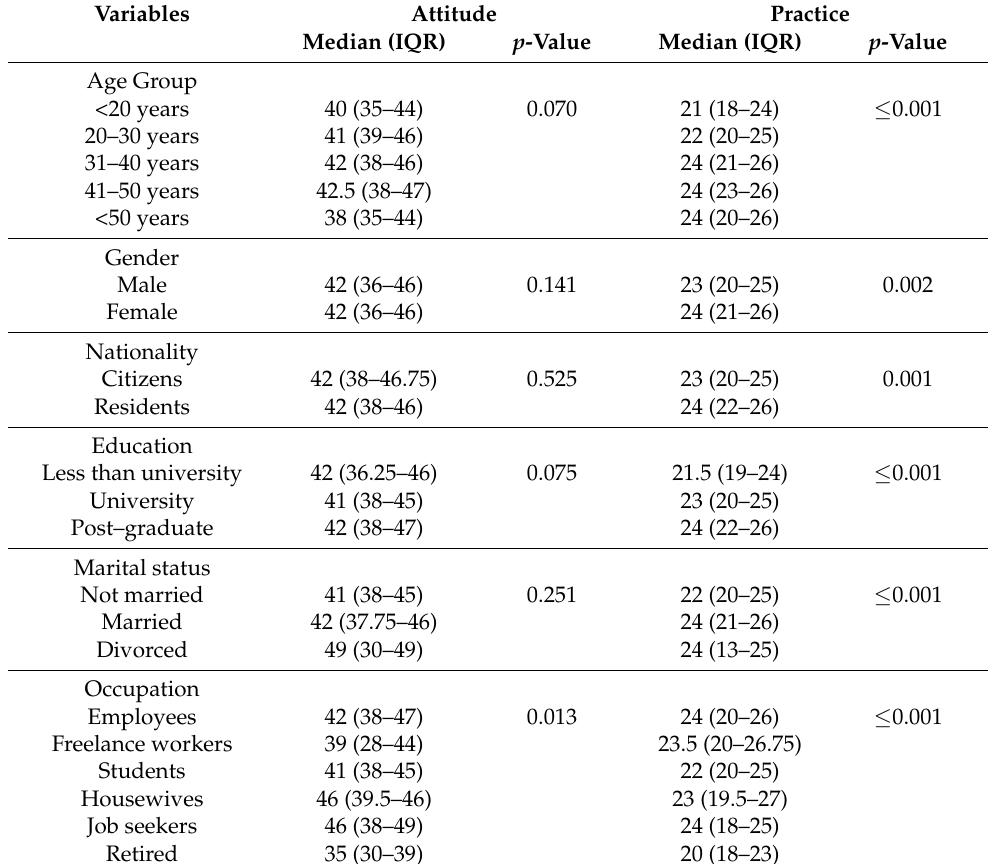
Table 4. Demographic characteristics and median of Islamic attitude and practices among